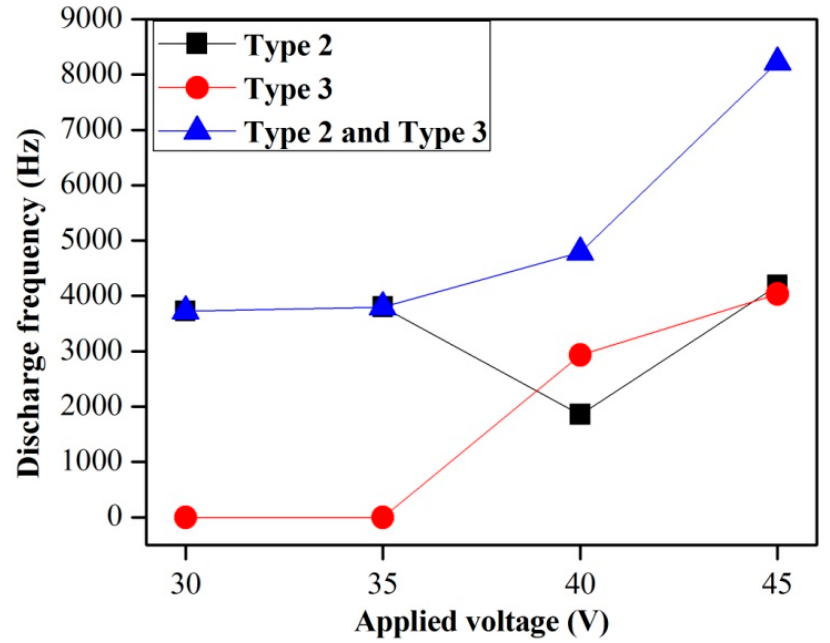
Figure 11. Discharge frequencies for different applied voltages.